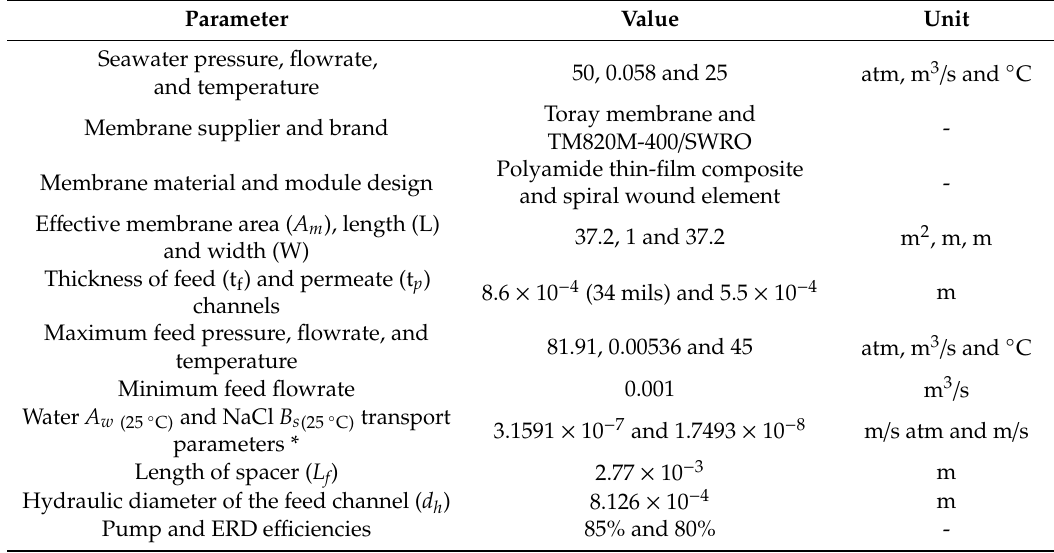
Table 2. Specifications of reverse osmosis (RO) process and membrane manufacturer data (adapted from